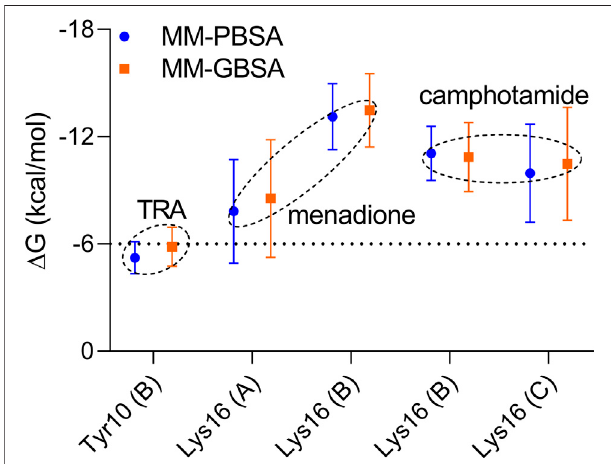
FIGURE 6 | Pairwise energy decomposition analysis using 100 ns MD trajectories of analyzed compounds bound to A β peptide as implicit solvation MM-PBSA/GBSA models. The information about A β chains is added in brackets. The energy threshold is depicted as a dotted line.